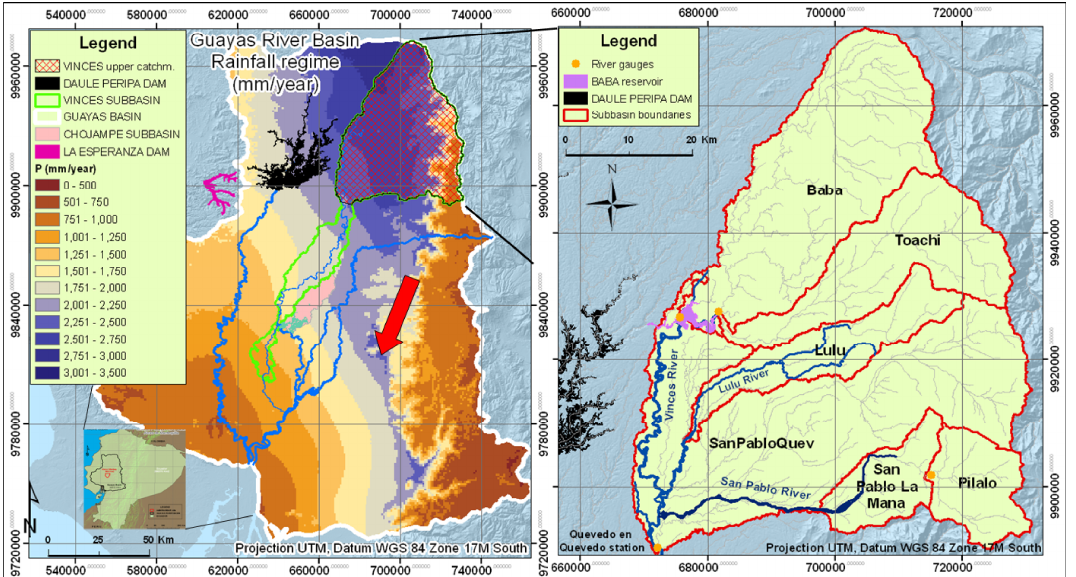
Fig. 1. Left: Guayas River basin, system flow direction (arrow) and main features; right: hydrological model schematization for the Vinces upper